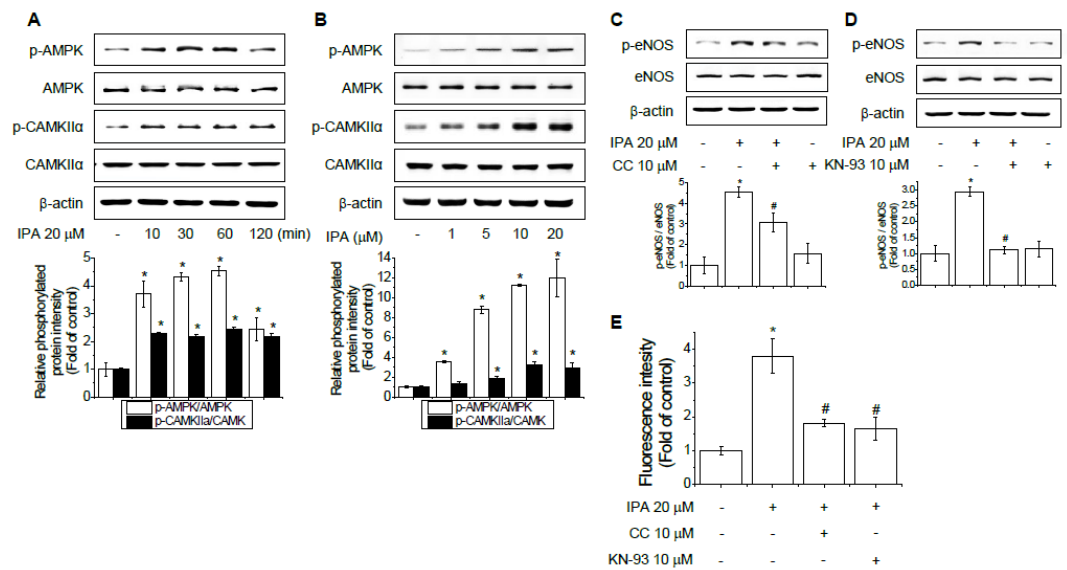
Figure 3. Phosphorylation of eNOS induced by IPA is mediated by 5′ AMP-activated protein kinase (AMPK) and Ca2+ calmodulin-dependent protein kinase II (CaMKII). Immunoblots of EA.hy926 cell lysates treated with 20 μM IPA for 10, 30, 60, and 120 min ( A ) or with different concentrations of IPA (1, 5, 10, and 20 μM) for 60 min ( B ). EA.hy926 cells were treated with 10 μM of the AMPK inhibitor compound C ( C ) or 10 μM of the CaMKII inhibitor KN-93 ( D ) for 1 h, followed by incubation with or without 20 μM IPA for an additional hour. NO production was analyzed with the NO-specific fluorescent dye DAF-2 DA kit at 495/515 nm ( E ). Data are means ± SD of three independent experiments. * p < 0.05 compared with control. # p < 0.05 compared with IPA treatment.